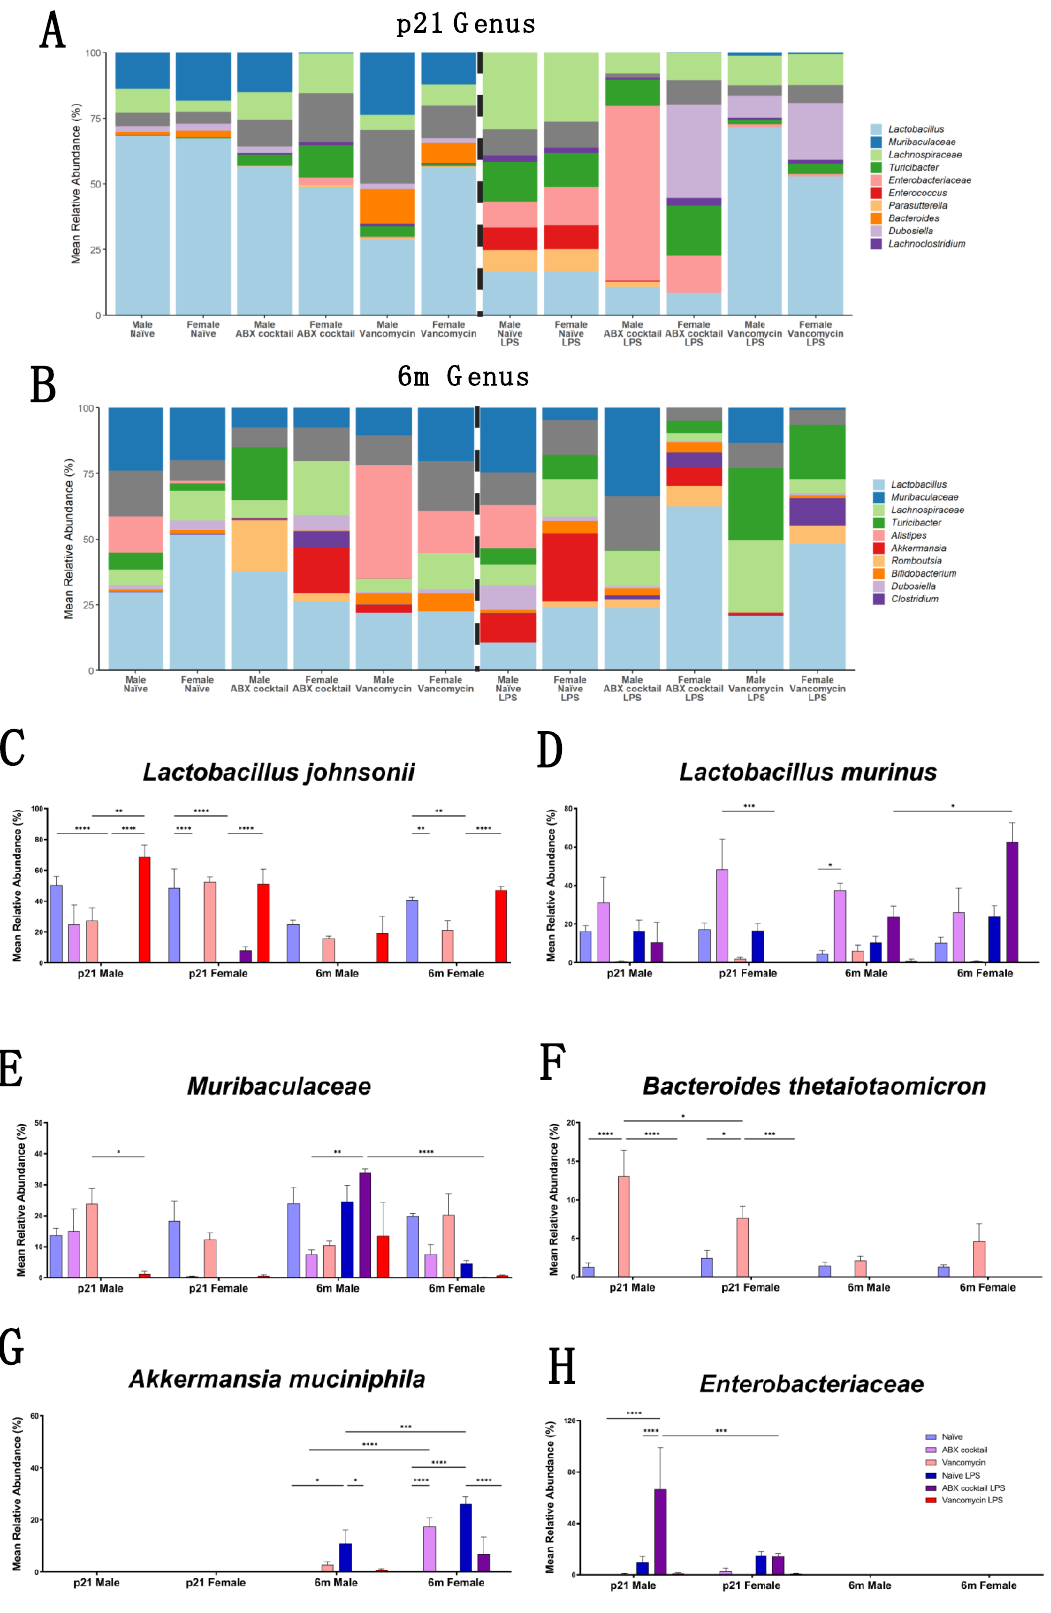
Figure 3. Taxonomy representation at genus and species level. ( A , B ) Relative abundances of se- quences classified to genus at p21 and 6m respectively, with Lactobacillus being the most abundant in both. Only the top 10 genera in each are shown, the remaining are summed and greyed. ( C )